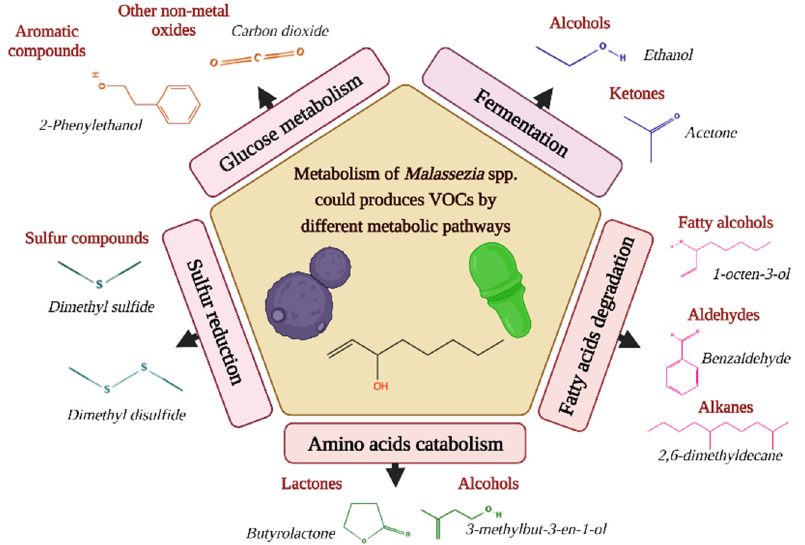
Figure 6. Different metabolic pathways can produce volatile organic compounds (VOCs) in Malassezia species. Representative examples are given per class of volatiles [13].